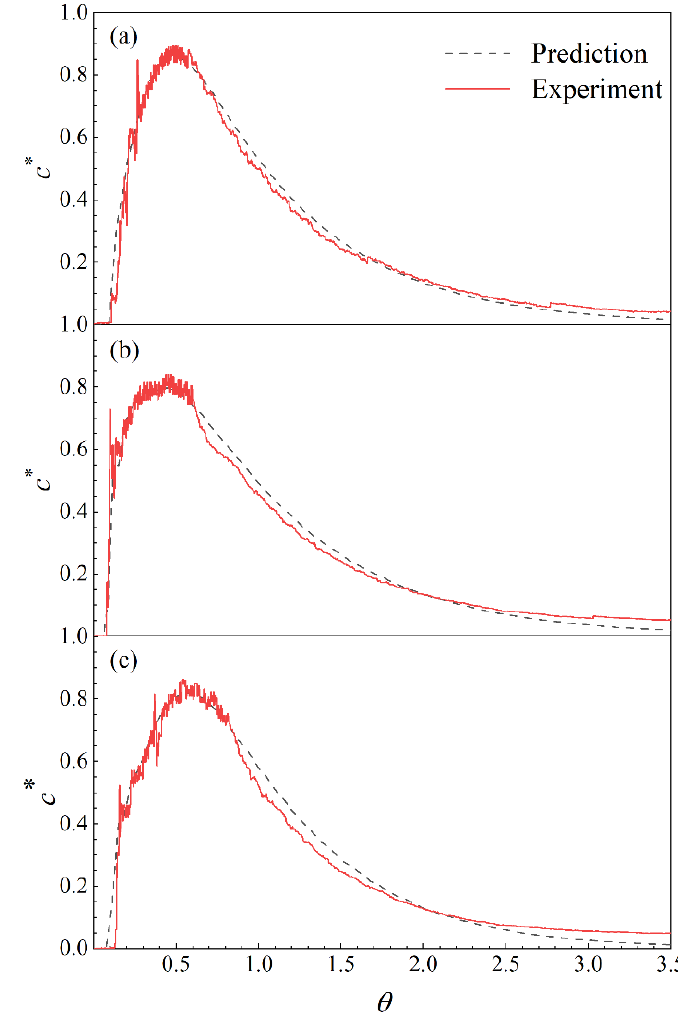
Figure 4. Comparison of calculated and experimental RTD: ( a ) water model of tundish A, ( b ) water model of tundish B, ( c ) water model of tundish C.